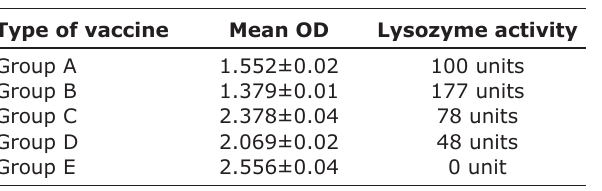
Table-2: Effect of the four vaccine formula on lysozyme activity of stimulated macrophages in tested sheep sera after 2 weeks from the challenge.